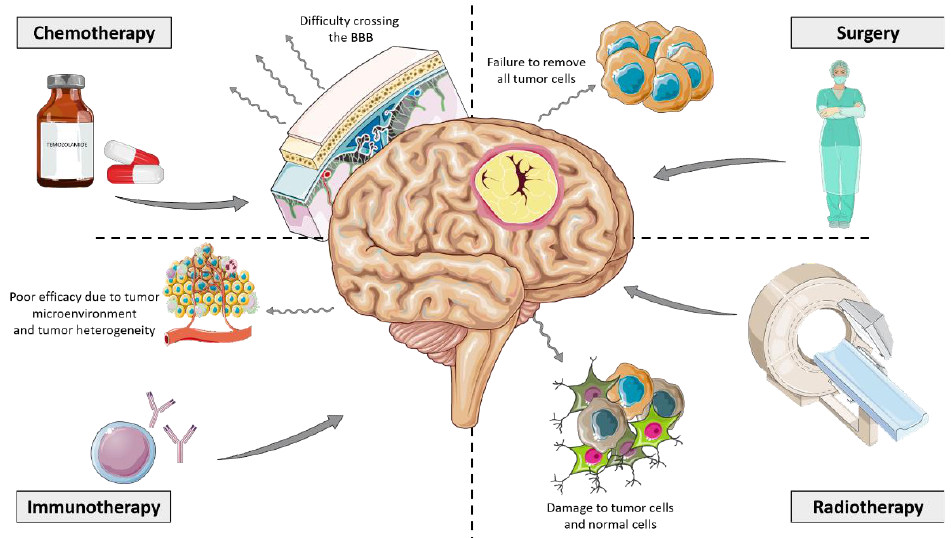
Figure 4. Conventional treatment modalities for GBM. Main treatment options for GBM patients are represented by solid straight lines. Limitations for these main treatments are schematized as refractory lines. This figure was created using Servier Medical Art templates, which are licensed under a Creative Commons Attribution 3.0 Unported License; https://smart.servier.com (accessed on 1 February 2023).